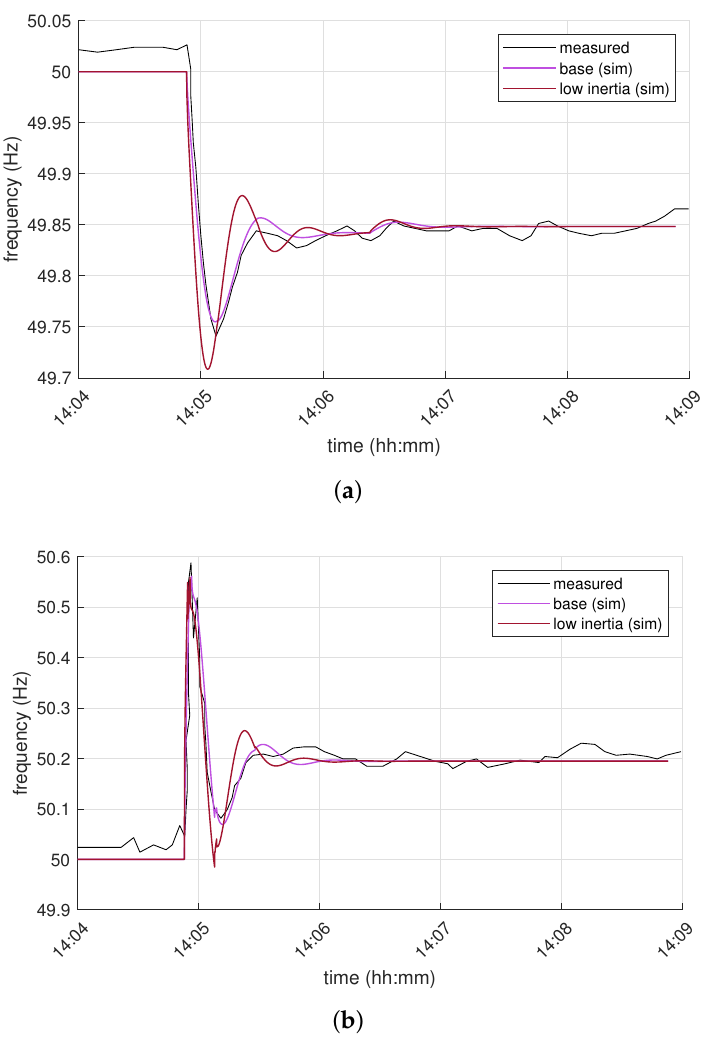
Figure 13. Comparison of simulation results for variant scenario of low inertia conditions: ( a ) fre- quency in North-West part; ( b ) frequency in South-East